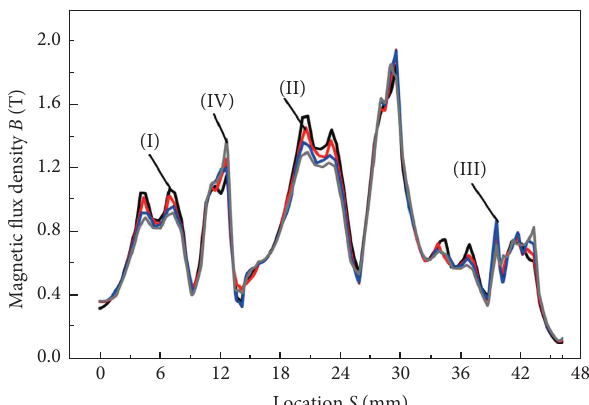
Figure 8: Distribution of magnetic field in larger radial clearance under different eccentricity of rotating shaft (I), 0; (II), 0.1/13.6; (III), 0.2/ 13.6; (IV), 0.3/13.6.